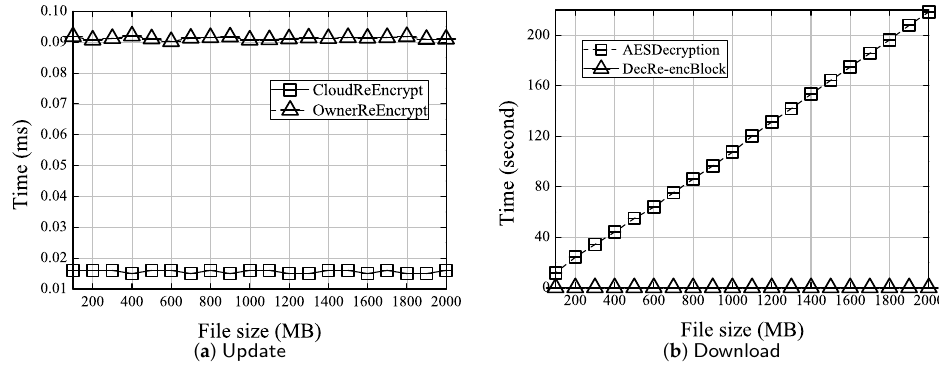
Figure 4. Computational cost for Update and Download phase.